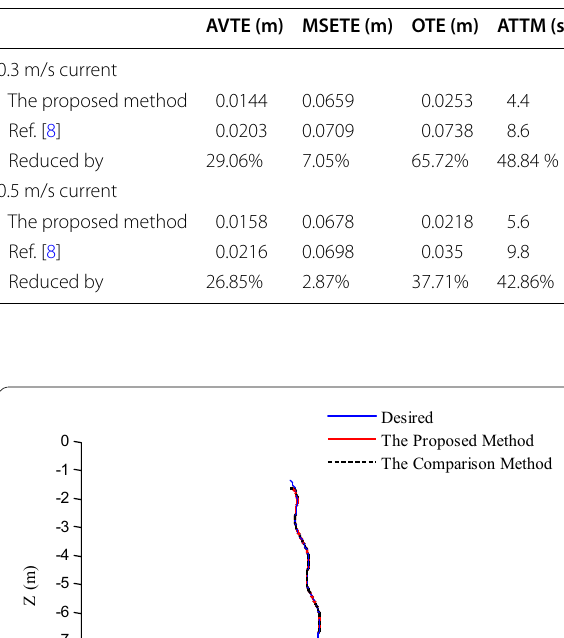
Table 2 Simulation data in different ocean current environment